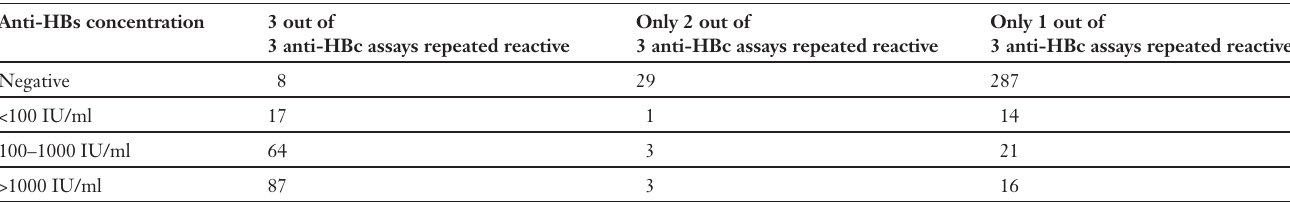
Concentrations of anti-HBs compared to the results of anti-HBc assays for donations from BTS Anti-HBs concentration